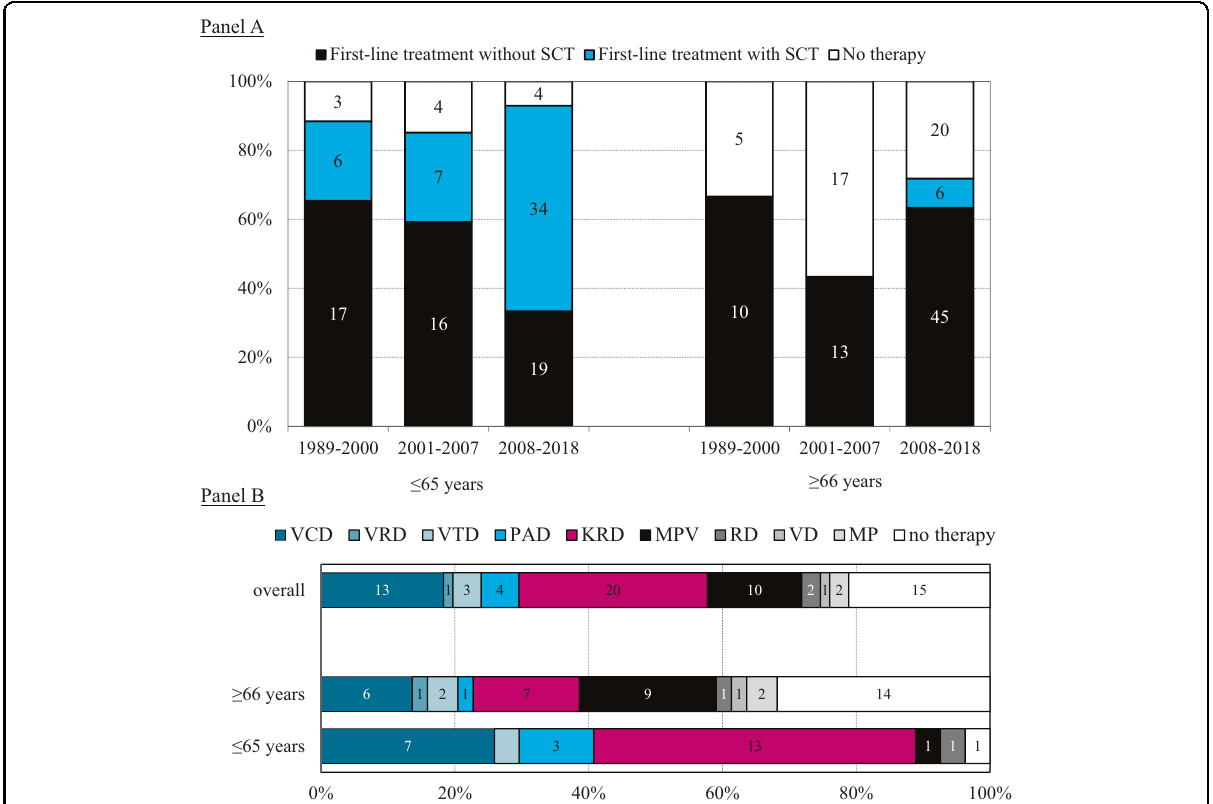
Fig. 1 First-line treatment of patients with pPCL in the Netherlands. The absolute numbers of patients are depicted in the bars. A The fi rst-line treatment for patients diagnosed with pPCL between 1989 and 2018 according to age at diagnosis and calendar period of diagnosis. B The information on the exact therapeutic regimen for diagnosed patients with pPCL between 2014 and 2018 according to age at diagnosis. Of note, patients who received KRD were treated within the setting of a clinical trial. pPCL primary plasma cell leukemia, SCT stem cell transplantation, bortezomib-dexamethasone (VD), VD with cyclophosphamide (VCD), VD with lenalidomide (VRD), VD with thalidomide (VTD), lenalidomide- dexamethasone (RD), RD with car fi lzomib (KRD), VD with doxorubicin (PAD), melphalan-prednisone (MP), and MP with bortezomib